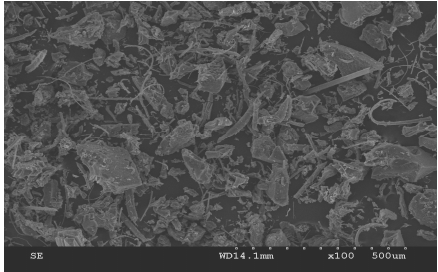
Figure 5. SEM analysis of